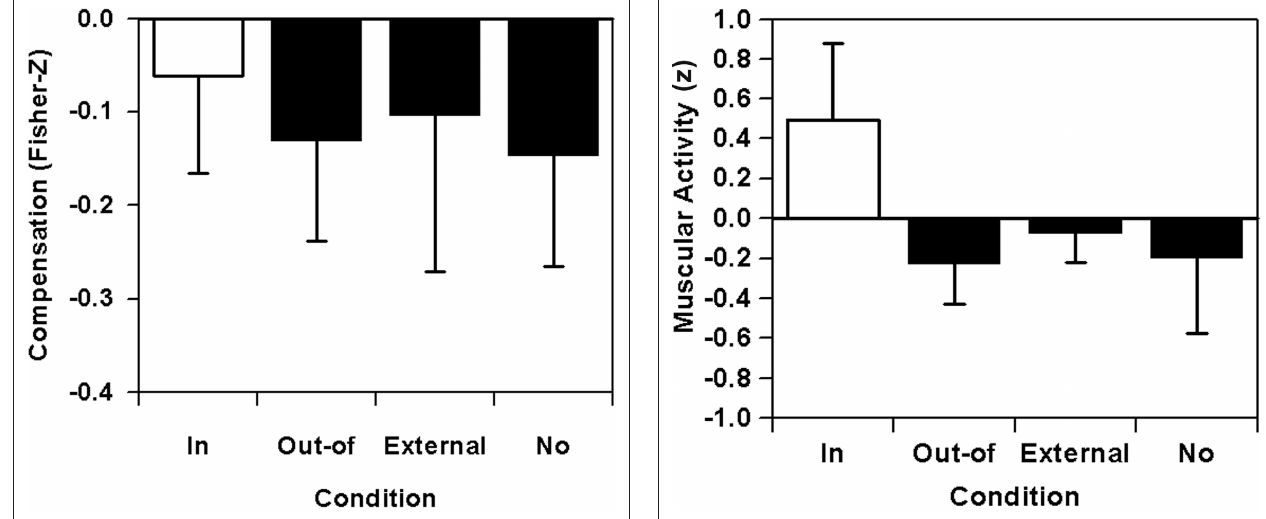
Figure 9 | Basketball free throws: relative muscular activity (eA) combined across the two nodal points as a function of focus of attention on the nodal point (in-focus), on the other nodal point (out-of-focus), on the basket (external), or without any special instruction